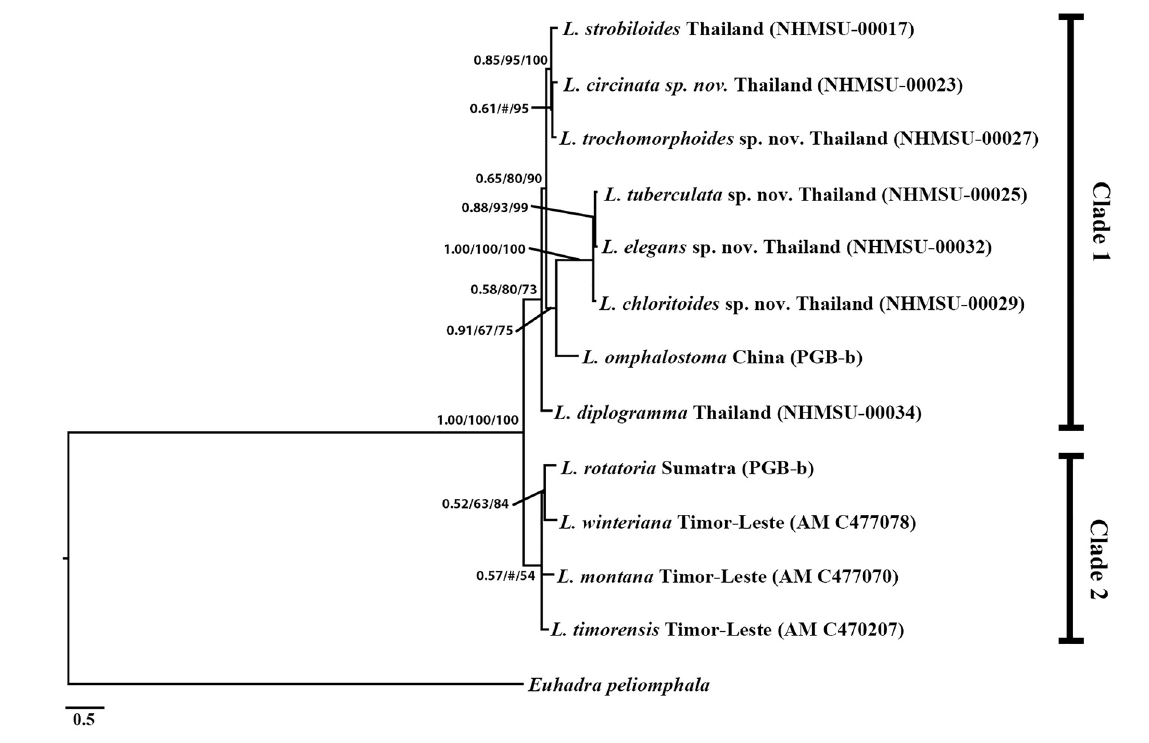
Fig. 2. Bayesian majority-rule consensus tree summarizing the phylogenetic relationships of species of Landouria Godwin-Austen, 1918 based on concatenated COI and 16S sequences. Numbers at nodes indicate branch support based on posterior probability (BI) / bootstrapping (ML) / bootstrapping (NJ). # indicates branches that received < 50% ML, NJ bootstrap support. Scale bar = 0.5